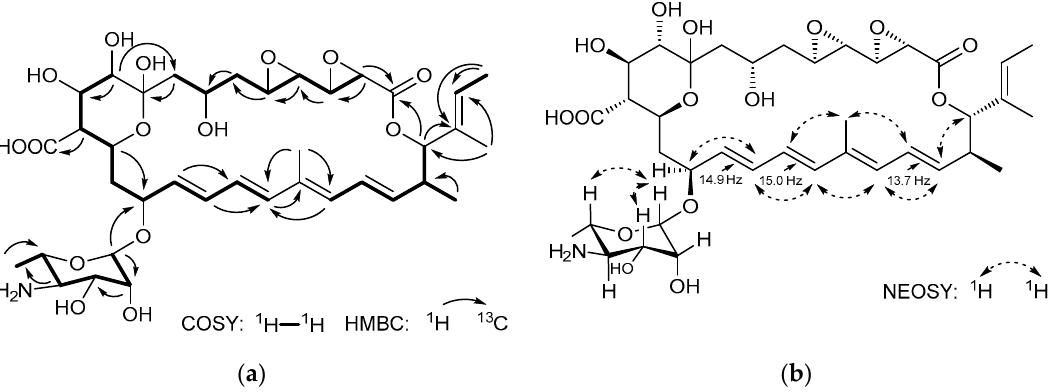
Figure 3. Planar structure of actinospene ( 1 ) showing 2D NMR correlations. ( a ) Observed COSY and HMBC correlations; ( b ) NOESY correlations, and the diagnostic 1 H- 1 H coupling constants.